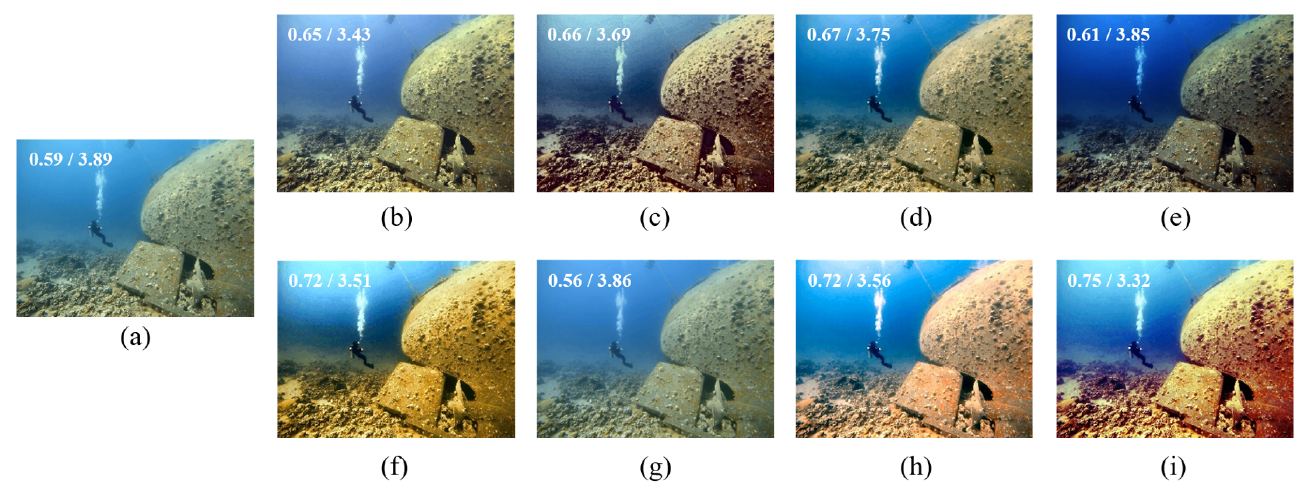
Figure 4. ( a ) Bright bluish underwater image, and its restored/enhanced results obtained using ( b ) Fusion-based[43], ( c ) Retinex-based[44], ( d ) IBLA[10], ( e ) AGC[45], ( f ) GDCP[9], ( g ) UWCNN[26], ( h ) BL-TM[40], and ( i ) the proposed method. The number on the top-left corner of each image refers to its UCIQE/NIQE